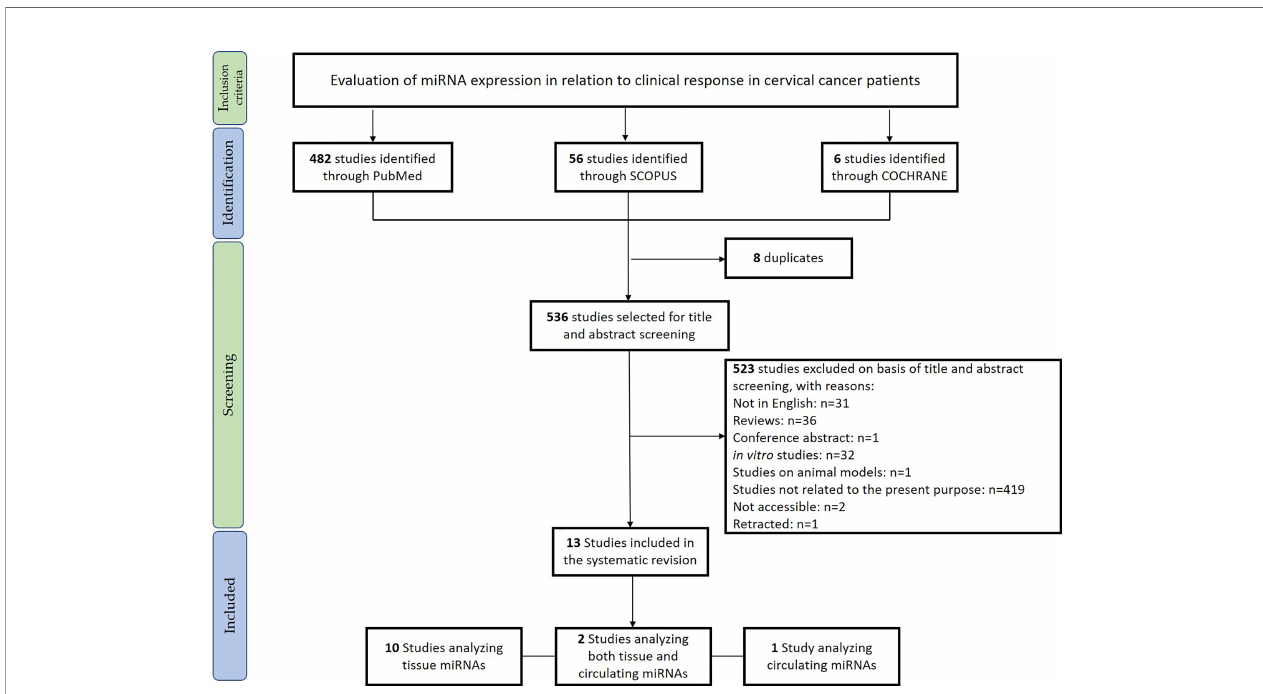
FIGURE 1 | Preferred Reporting Items for Systematic Reviews and Meta-Analyses (PRISMA) fl owchart for the studies included in the systematic